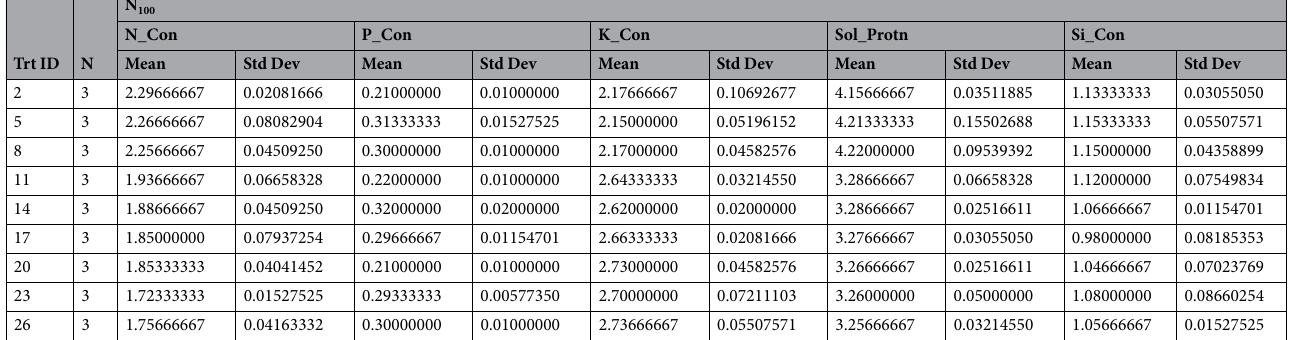
Table 3. Summary statistics from one-way MANOVA of treatment groups for the level of the N factor = 100 units, which are used for multi-dimensional plotting with BPH fitness criteria.